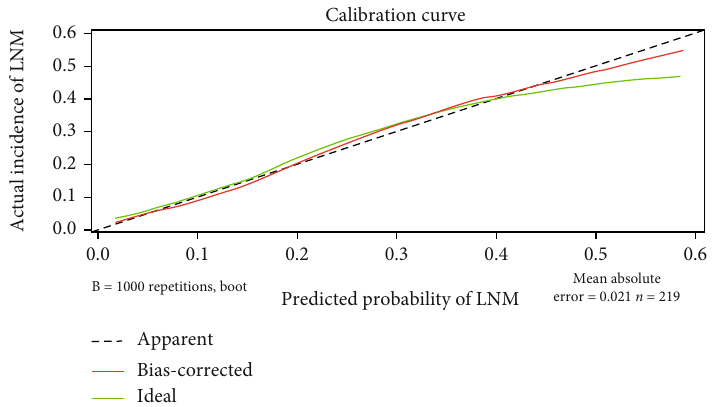
Figure 3: Internal veri fi cation plots of the nomogram calibration curves by 10-fold cross-validation.